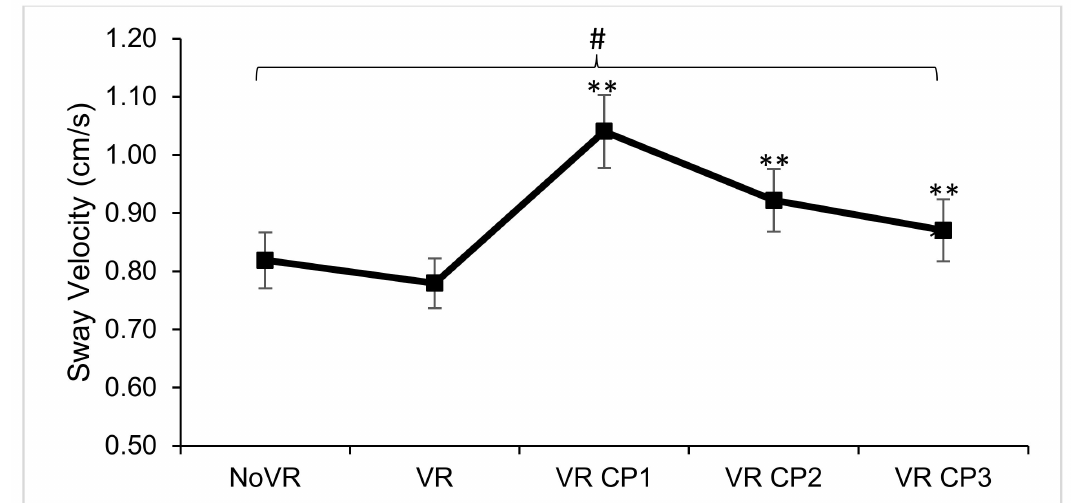
Figure 3. Sway velocity (cm/s) during upright bilateral stance with no virtual reality (NoVR), with virtual reality (VR), first trial in virtual environment with room walls closing in (VR CP1), second trial (VR CP2), and third trial (VR CP3). # represents main effect significance and * represent post-hoc pairwise comparison significance. Bars represent standard errors. ** implies significant difference from first two conditions.